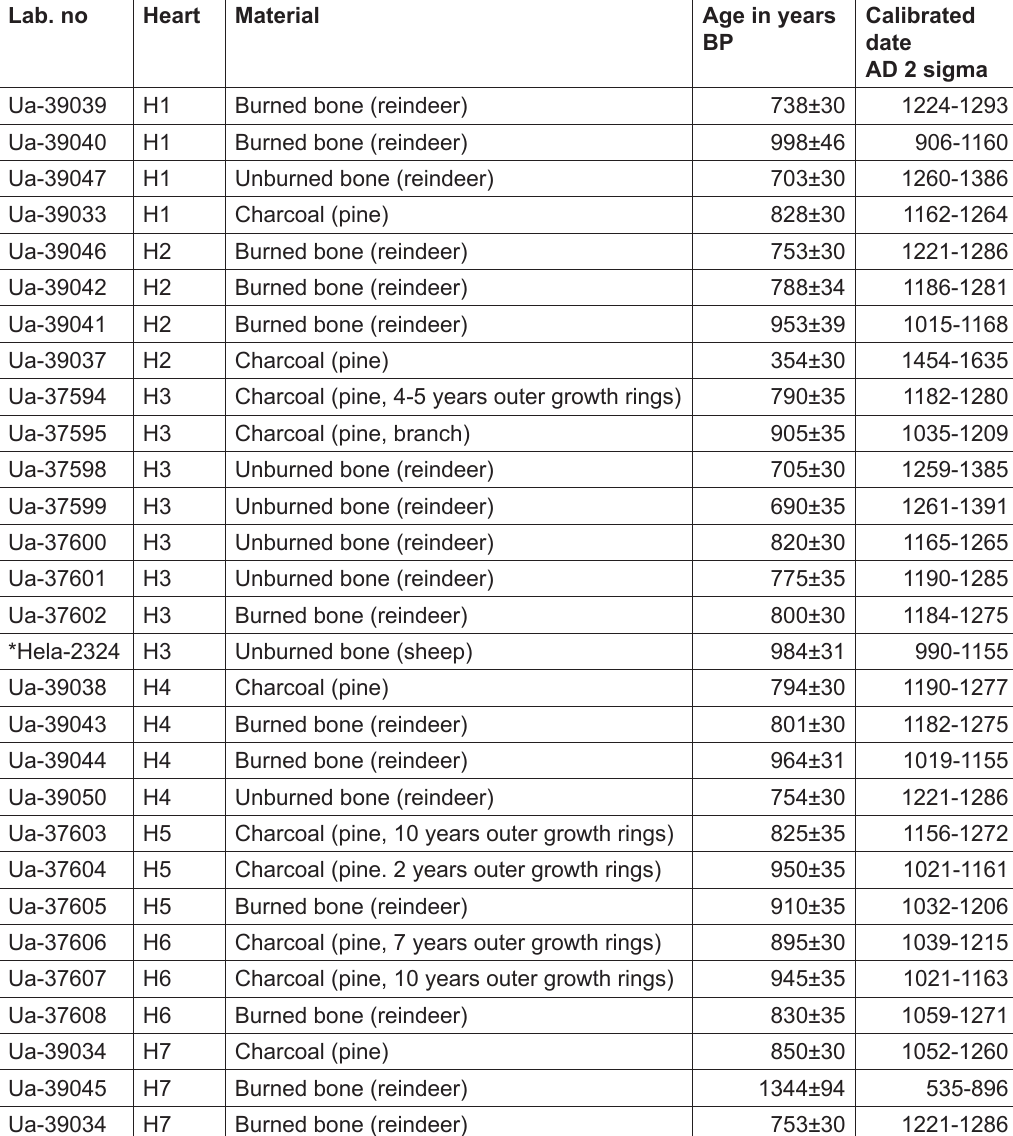
Table 7. AMS radiocarbon dates from Brodtkorbneset. Dates calibrated using OxCal 4.2 (Bronk Ramsey 2009). Lab.